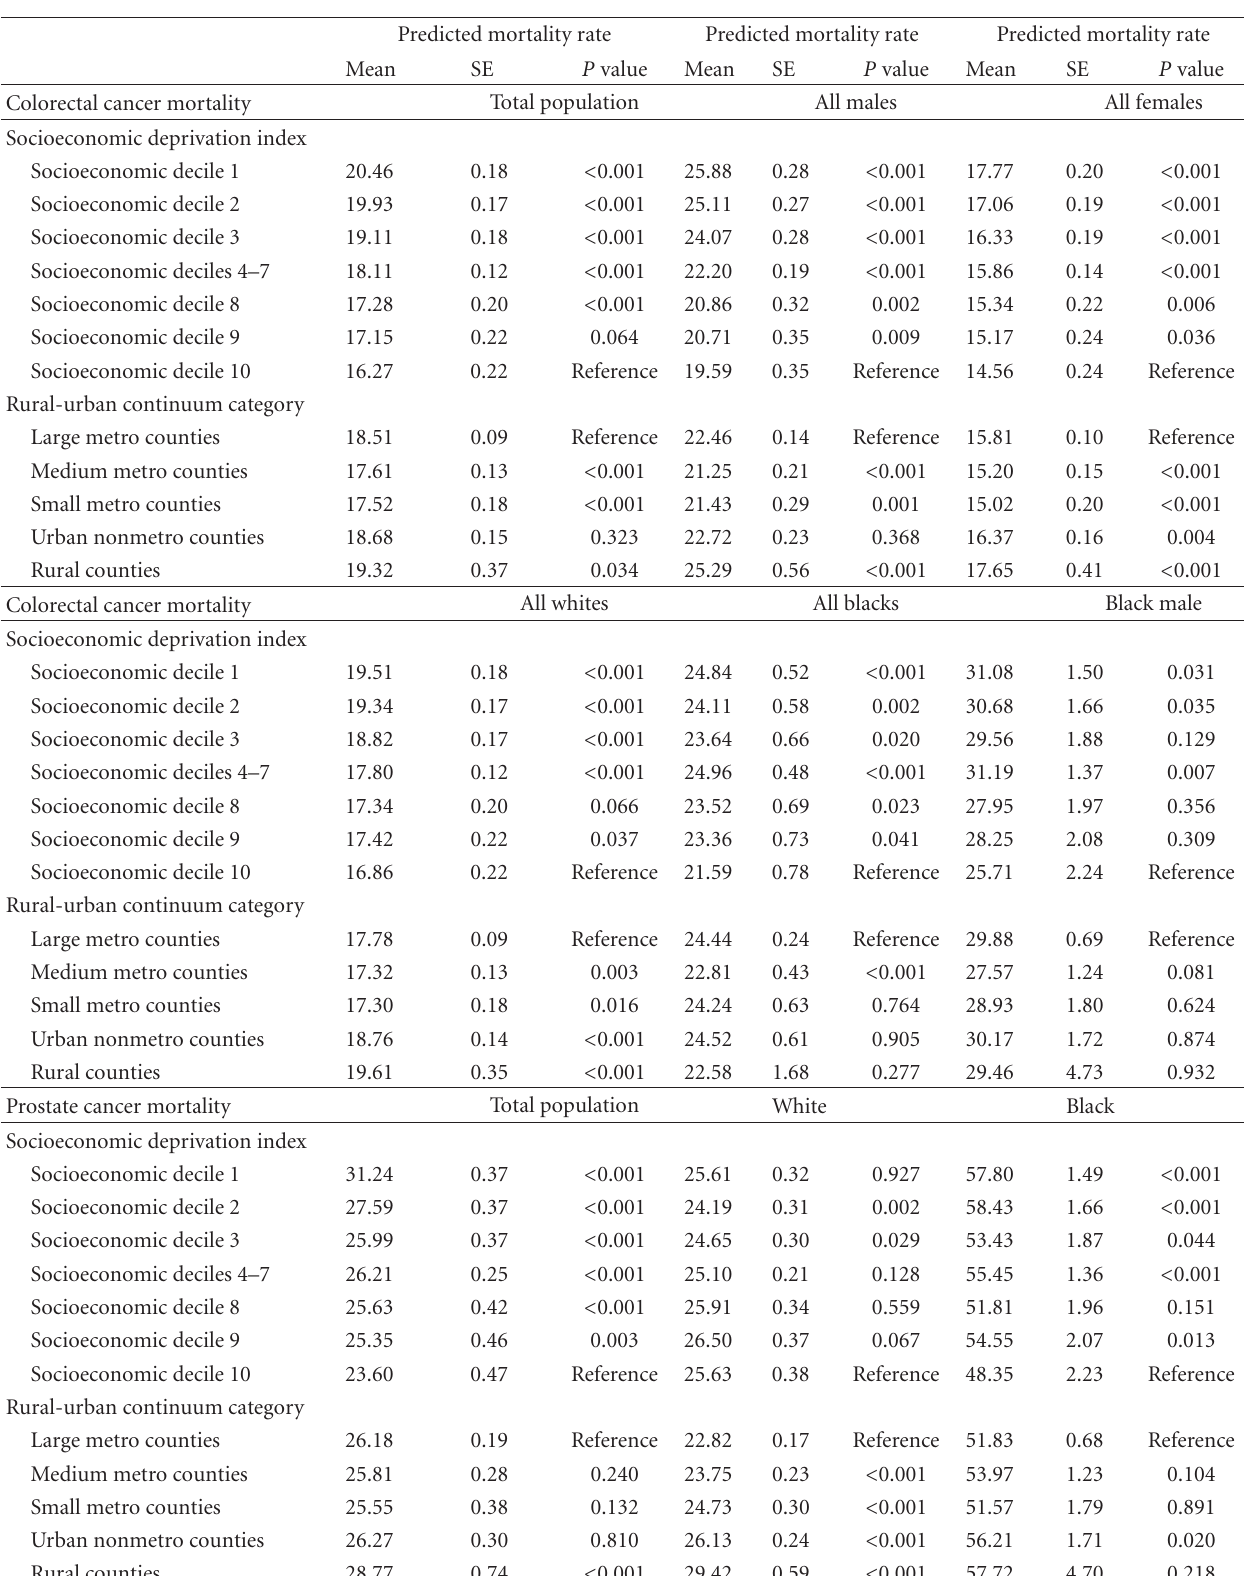
Table 6: Multivariate weighted least squares regression models showing adjusted di ff erentials in colorectal, prostate, breast, and